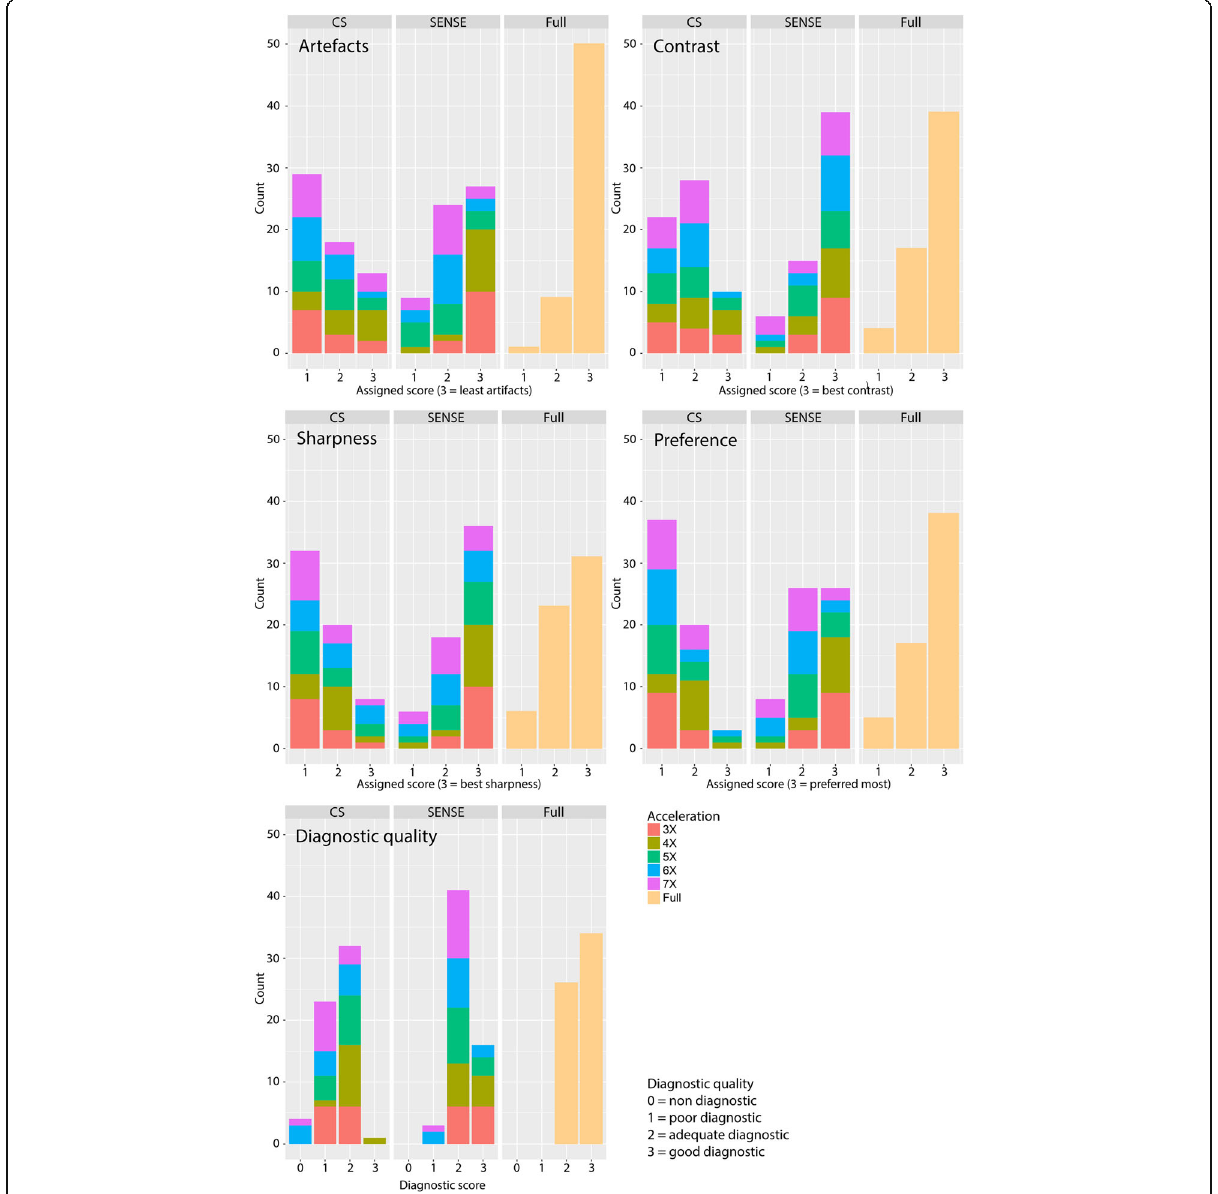
Fig. 6 Histograms of static experiment representing the distribution of the accelerated datasets per scored value among the various scoring variables. CS compressed sensing, SENSE sensitivity encoding, Full fully sampled three-dimensional balanced fast